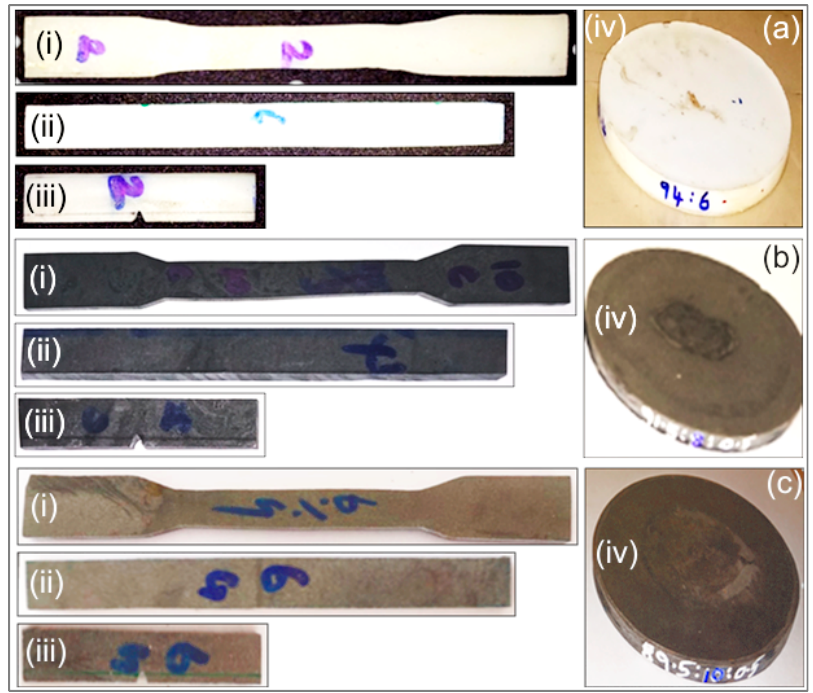
Figure 3. Photographs of specimens: ( a ) HGM/E composites, ( b ) HGM/CNT/E composites, and ( c ) HGM/G/E composites; ( i ) tensile, ( ii ) flexural, ( iii ) impact, and ( iv ) thermal conductivity. Theoretical density ( ρ th ) is calculated using the mixing rule and is represented by